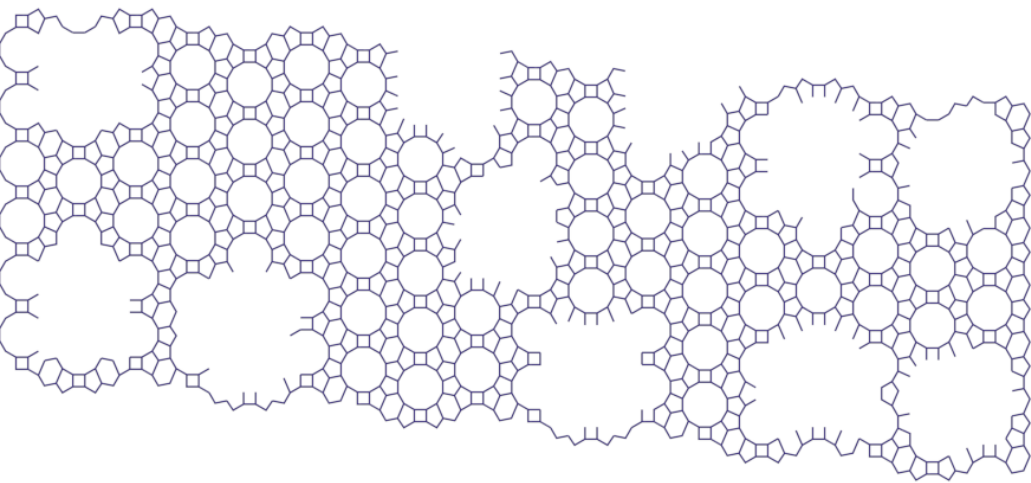
Figure 18. The model structure of sample 3 [compiled by the authors]. Figure 19 shows the model structures of samples